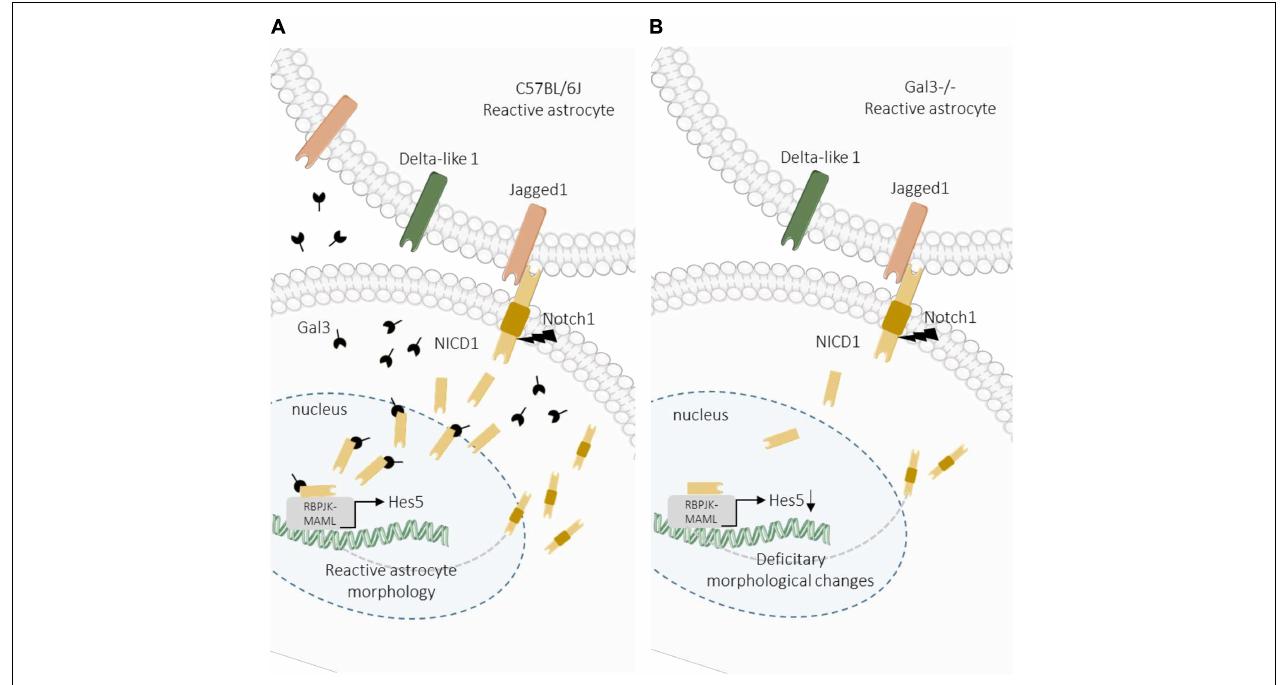
FIGURE 6 | Proposed model for Gal3 modulation of Notch1/Jagged1 signaling in reactive astrocytes. (A) After TBI in wild type mice, Notch1/Jagged1 signaling is activated in astrocytes, and NICD1 nuclear translocation and Hes5 transcription activation are Gal3-dependent. Activation of Notch1 signaling promotes astrocyte morphological response to TBI. (B) In Gal3 − / − mice, after TBI Notch1 signaling is activated at the lesion core, possibly through Jagged1, however activation is less intense compared to wild type mice. We hypothesize that Gal3 modulates NICD1 signaling, which is necessary for astrocyte activation in response to TBI. In the absence of Gal3, NICD1 signaling is disrupted and astrocyte activation is